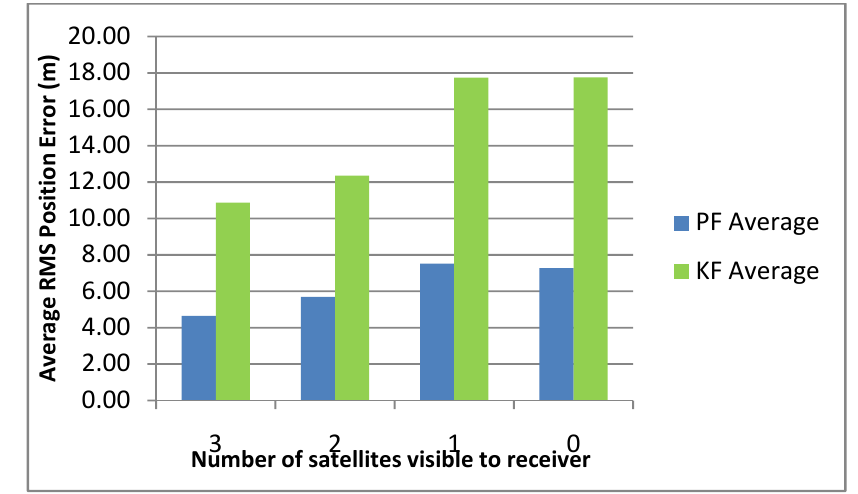
Figure 3. Average RMS position error over the 10 outages in Kingston trajectory.